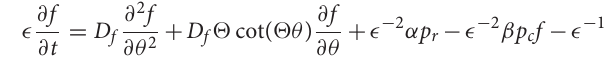
FIGURE 10 | Simulations of proportional cone loss for a range of inverse mutation-induced rod degeneration rates and TF threshold concentrations. Plots show the proportion of cones remaining compared to local healthy values, p c ( θ , t ) / ˜ p c ( θ ), across space and over time. (A,E,I,M) analytical inverse mutation-induced rod degeneration rate, φ r ( θ ) ( f crit = 3 × 10 − 5 ); (B,F,J,N) numerical φ r ( θ ) ( f crit = 3 × 10 − 5 ); (C,G,K,O) analytical inverse TF threshold concentration, f crit inv inv ( φ r = 7.33 × 10 − 2 ); (D,H,L,P) numerical f crit ( θ ) ( φ r = 7.33 × 10 − 2 ). (A–D) Uniform target cone degeneration profile, t degen ( θ ), with Scaling 1 ( α = 7.01 × 10 4 and inv β = 1.79 × 10 6 ); (E–H) Pattern 1A quadratic concave up t degen ( θ ) profile with Scaling 1; (I–L) Pattern 1B linear t degen ( θ ) profile with Scaling 2 ( α = 7.01 × 10 2 and β = 1.79 × 10 4 ); (M–P) Pattern 3 quadratic t degen ( θ ) profile with Scaling 2. Equations (1–5) were solved using the method of lines, with 26, 51 or 101 mesh points. Analytical and numerical